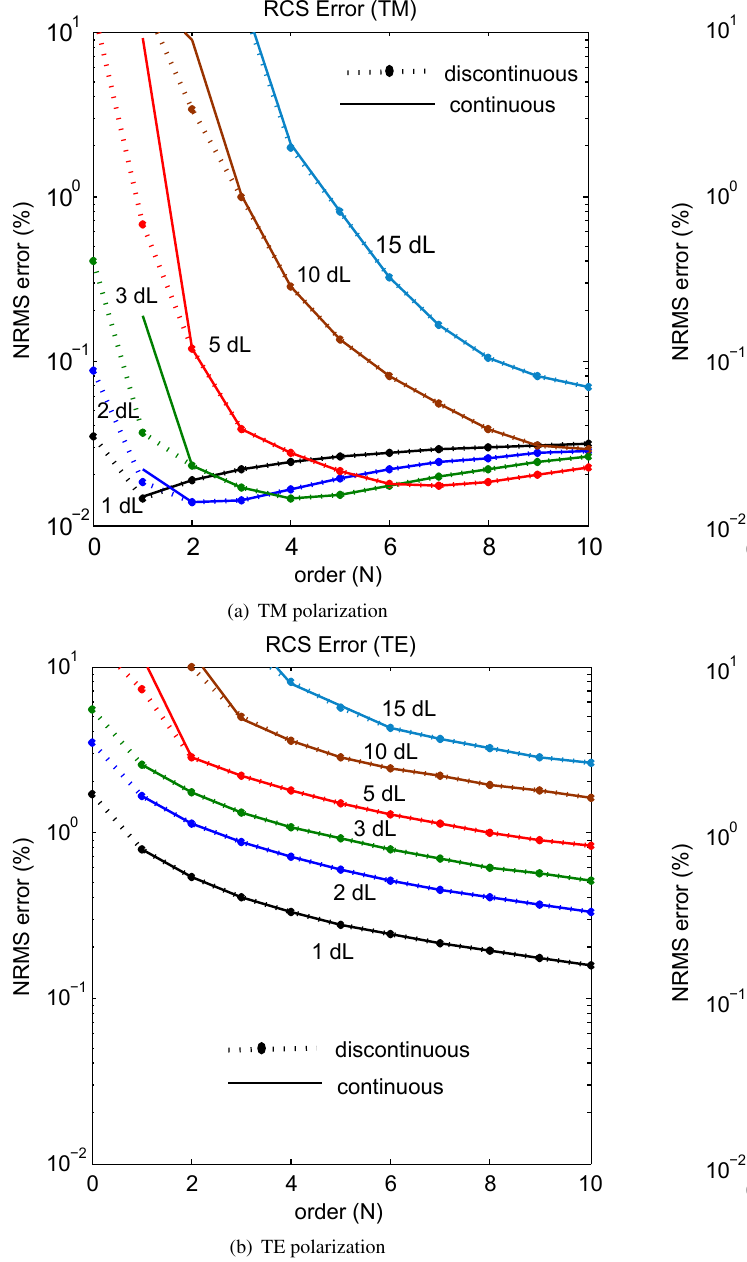
Figure 15: Log plot of RCS error versus the order and dL for λ = r ies.